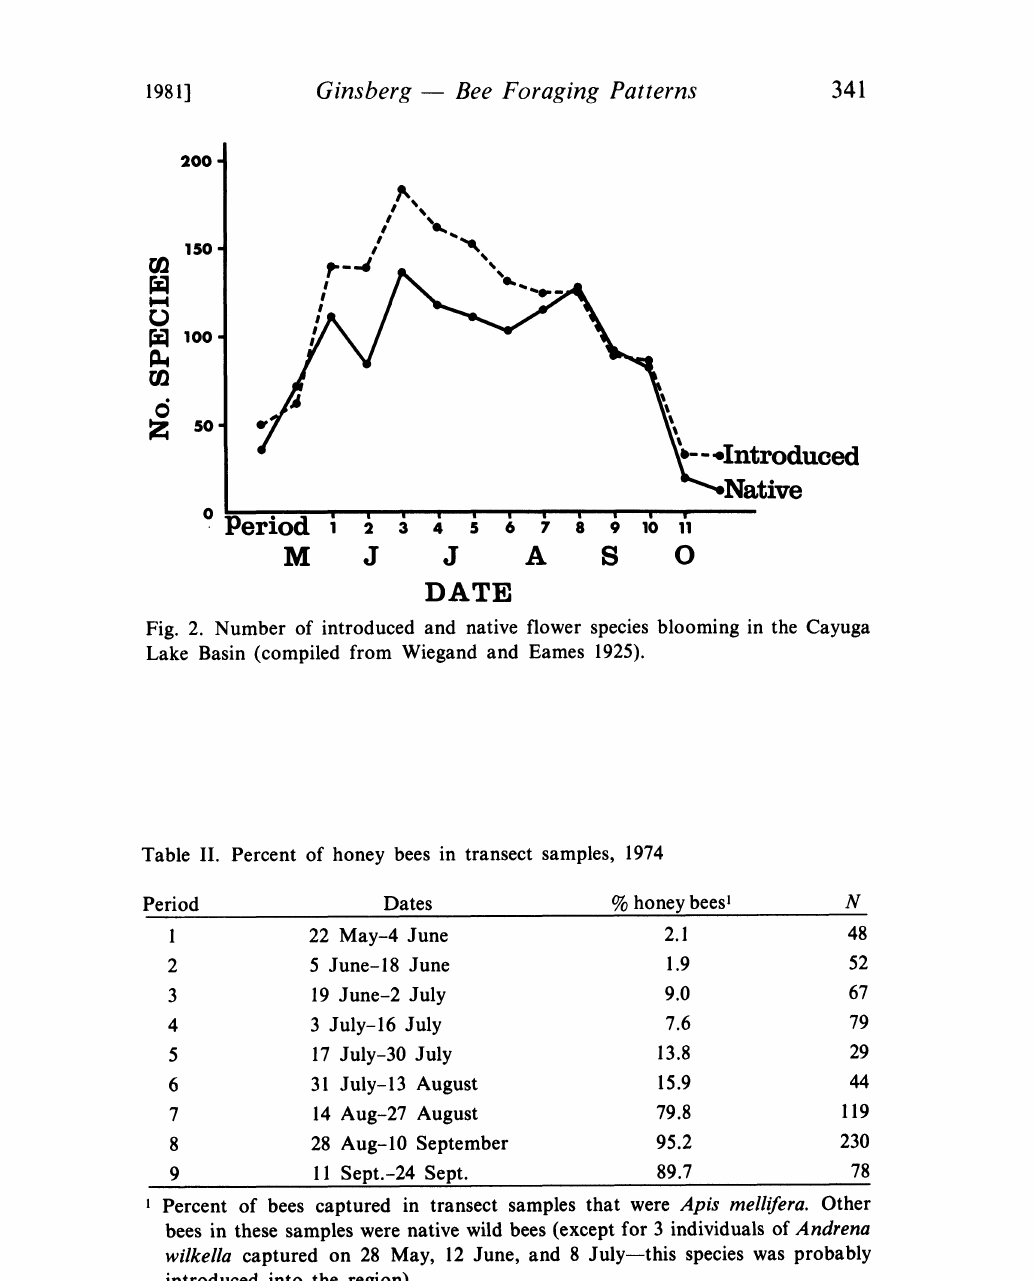
Table II. Percent of honey bees in transect samples,